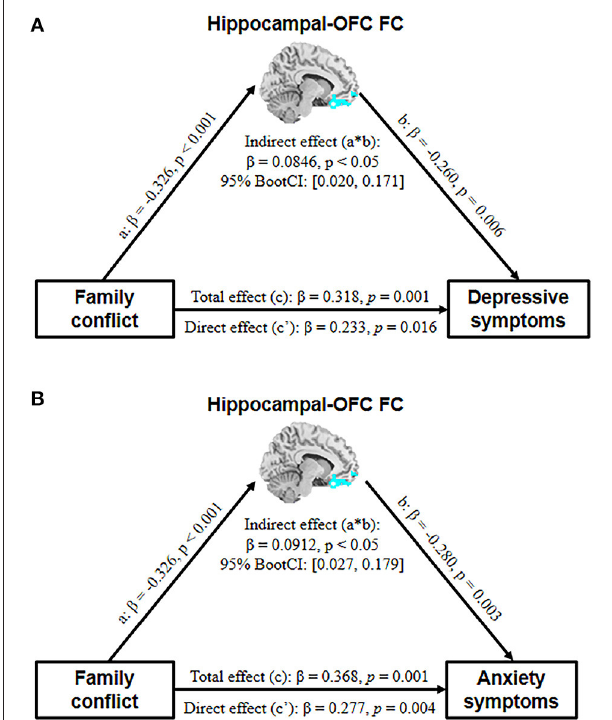
FIGURE 3 | The mediation model depicts the relationship between family conflict, adolescent depressive (A) and anxiety (B) symptoms, and hippocampal-OFC FC with age and gender as covariates (OFC, orbital frontal cortex; FC, functional